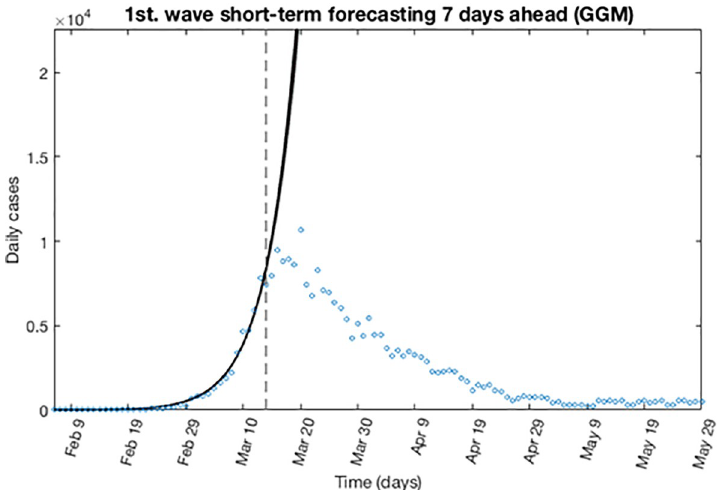
Fig 4. Short-term forecast. Forecasted curves for GGM for the first wave using 300 bootstrap realizations. The red line corresponds to the best fit of the forecasted epidemic curve. The black lines correspond to the 95% confidence bounds around the best fit of the forecasted curve, and grey lines correspond to the m bootstrapping realizations of the forecasted epidemic curves. The calibration period is separated from the forecast period with a vertical slashed grey